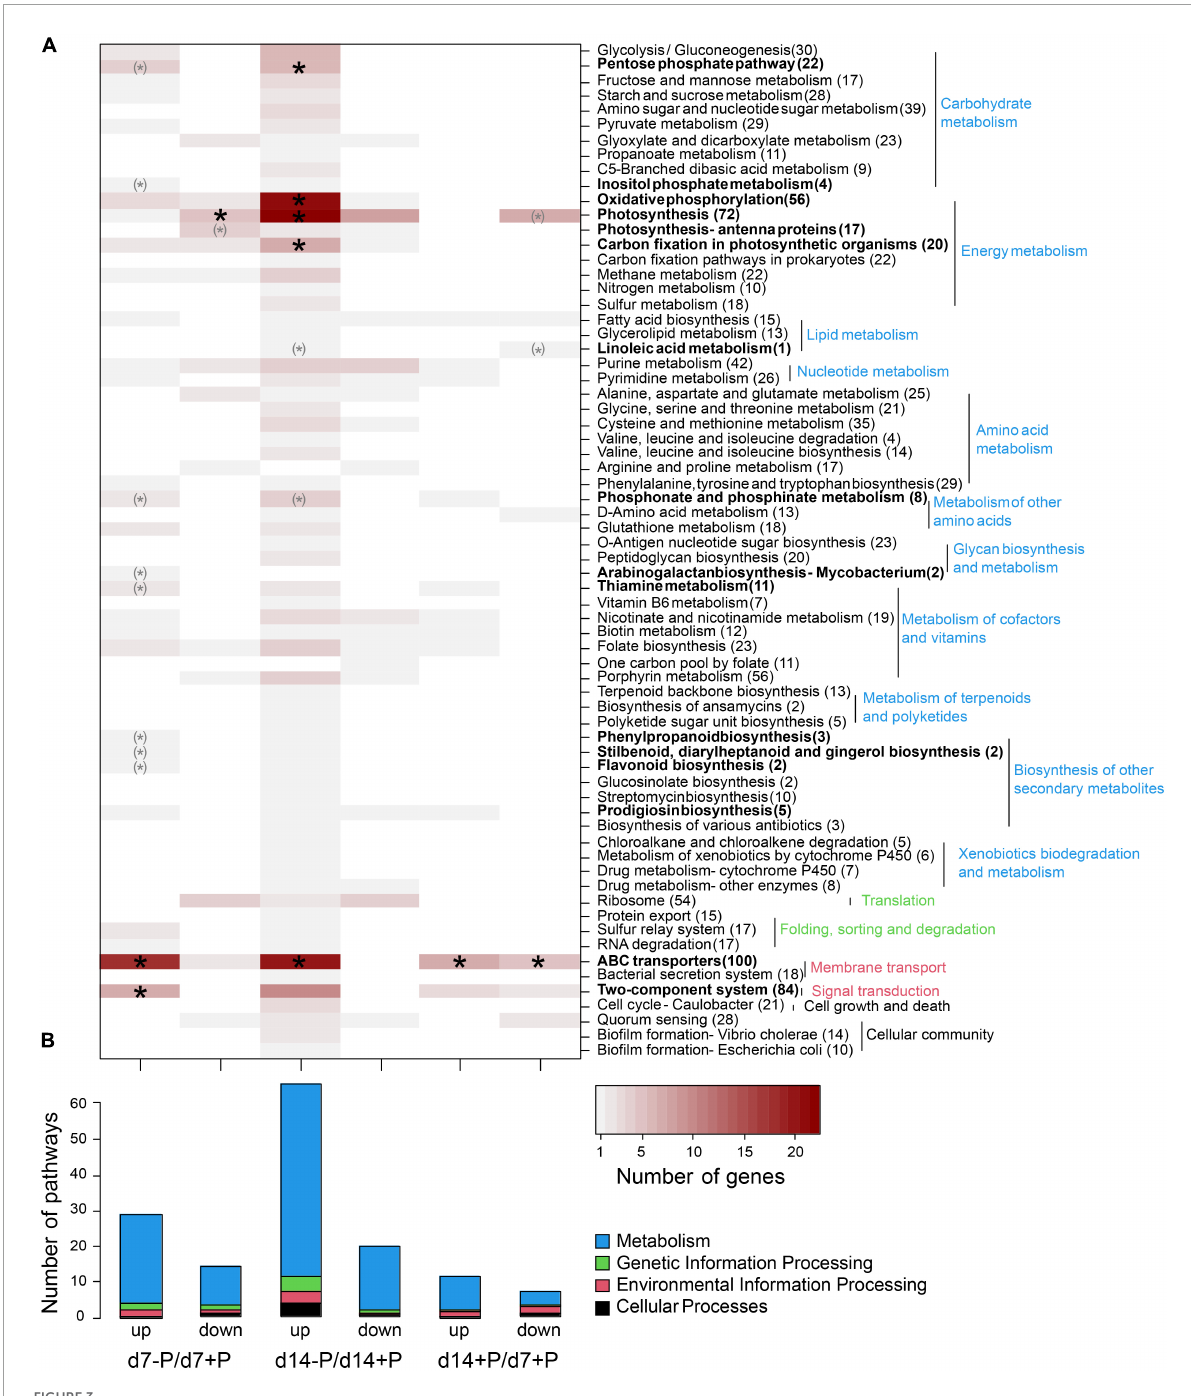
FIGURE3 Assignment of differentially expressed genes to KEGG pathways. Up- and down-regulated genes are shown for the comparison of P-deplete and P-replete conditions at d7, P-deplete and P-replete conditions at d14, and between P-replete conditions at d14 and d7. (A) Number of differentially expressed genes per KEGG pathway. Asterisks indicate significant functional enrichment (X 2 goodness-of-fit test, p < 0.05, parentheses indicate expected frequencies below 1). Number of genes per pathway in the genome is given after the pathway name. (B) Number of pathways containing differentially expressed genes. The RNA-seq experiment was conducted with samples from the second experiment